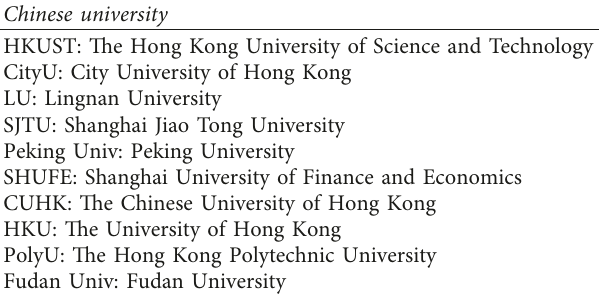
Table 9: The full names of all acronyms in Tables